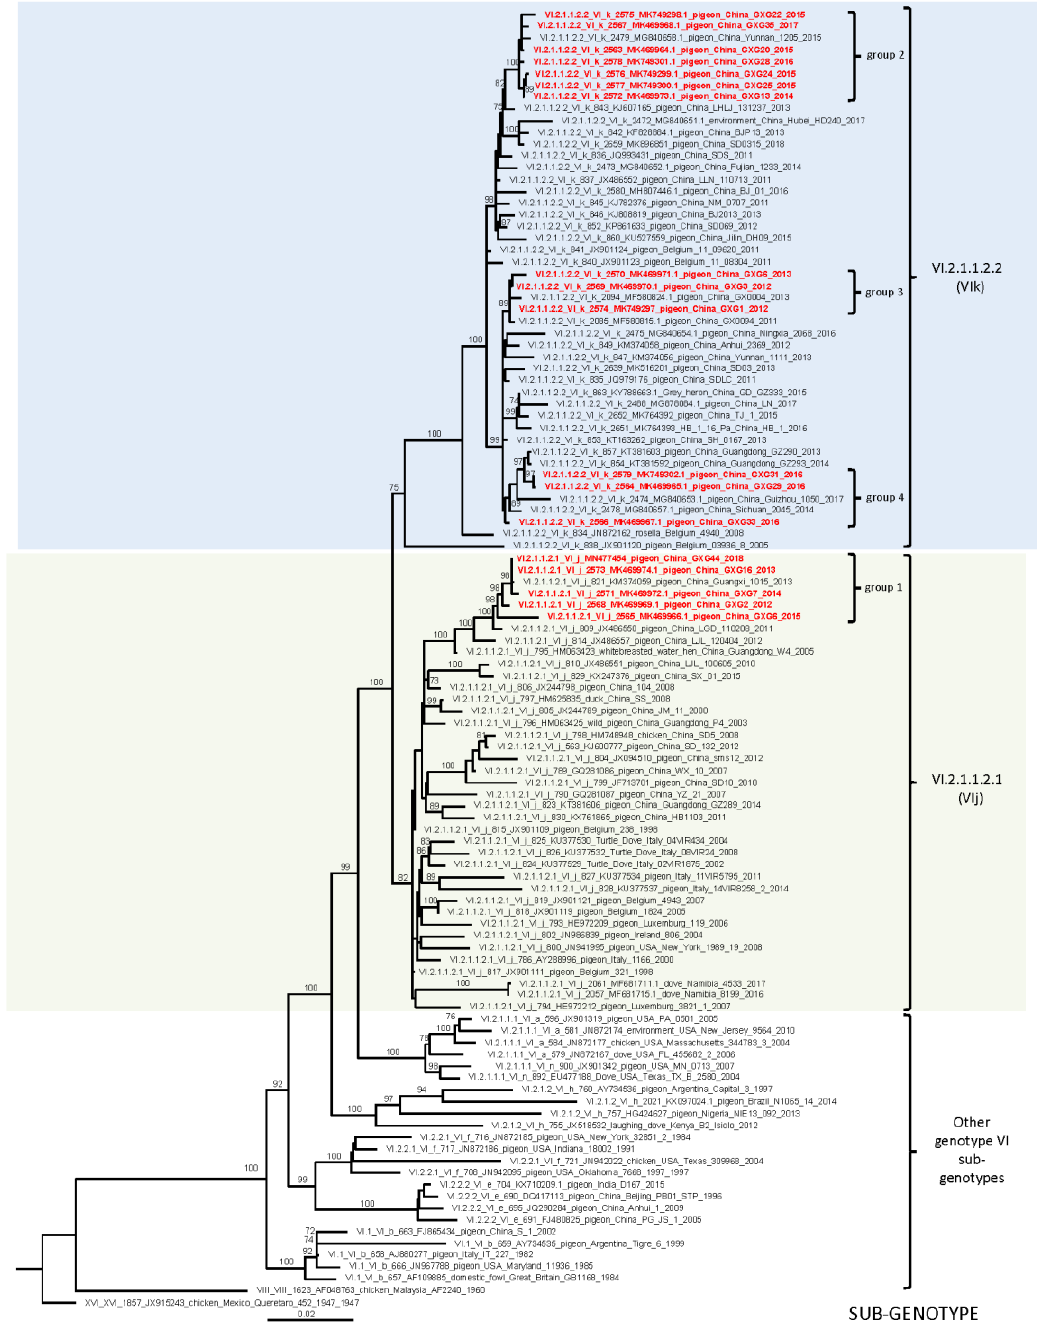
Figure 1. Phylogenetic analysis based on the full-length nucleotide sequence of the fusion gene of isolates representing Newcastle disease virus class II, sub-genotypes VI.2.1.1.2.1 and VI.2.1.1.2.2. The evolutionary history was inferred using the maximum likelihood method based on the general time reversible model with 1000 bootstrap replicates. The tree with the highest log likelihood ( − 12,395.64) is shown. A discrete gamma distribution was used to model evolutionary rate di ff erences among sites. The analysis involved 110 nucleotide sequences with a total of 1662 positions in the final dataset. The viruses isolated in this study are designated in red bold font. The Roman numerals presented in the taxa names in the phylogenetic tree represent the respective sub / genotype for each isolate, followed by the GenBank identification number, host name, country of isolation, strain designation, and year of isolation (if